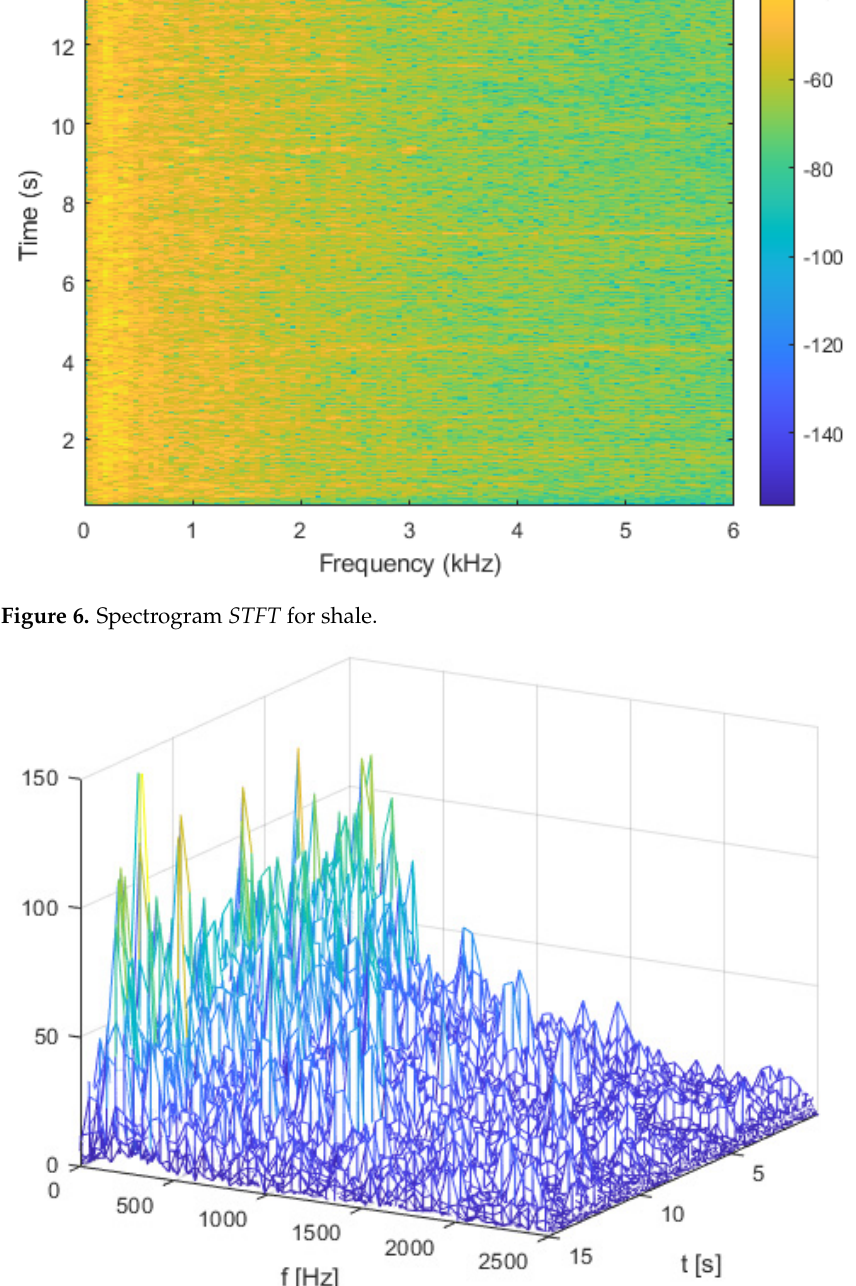
Figure 7. Three-dimensional graph STFT for shale.